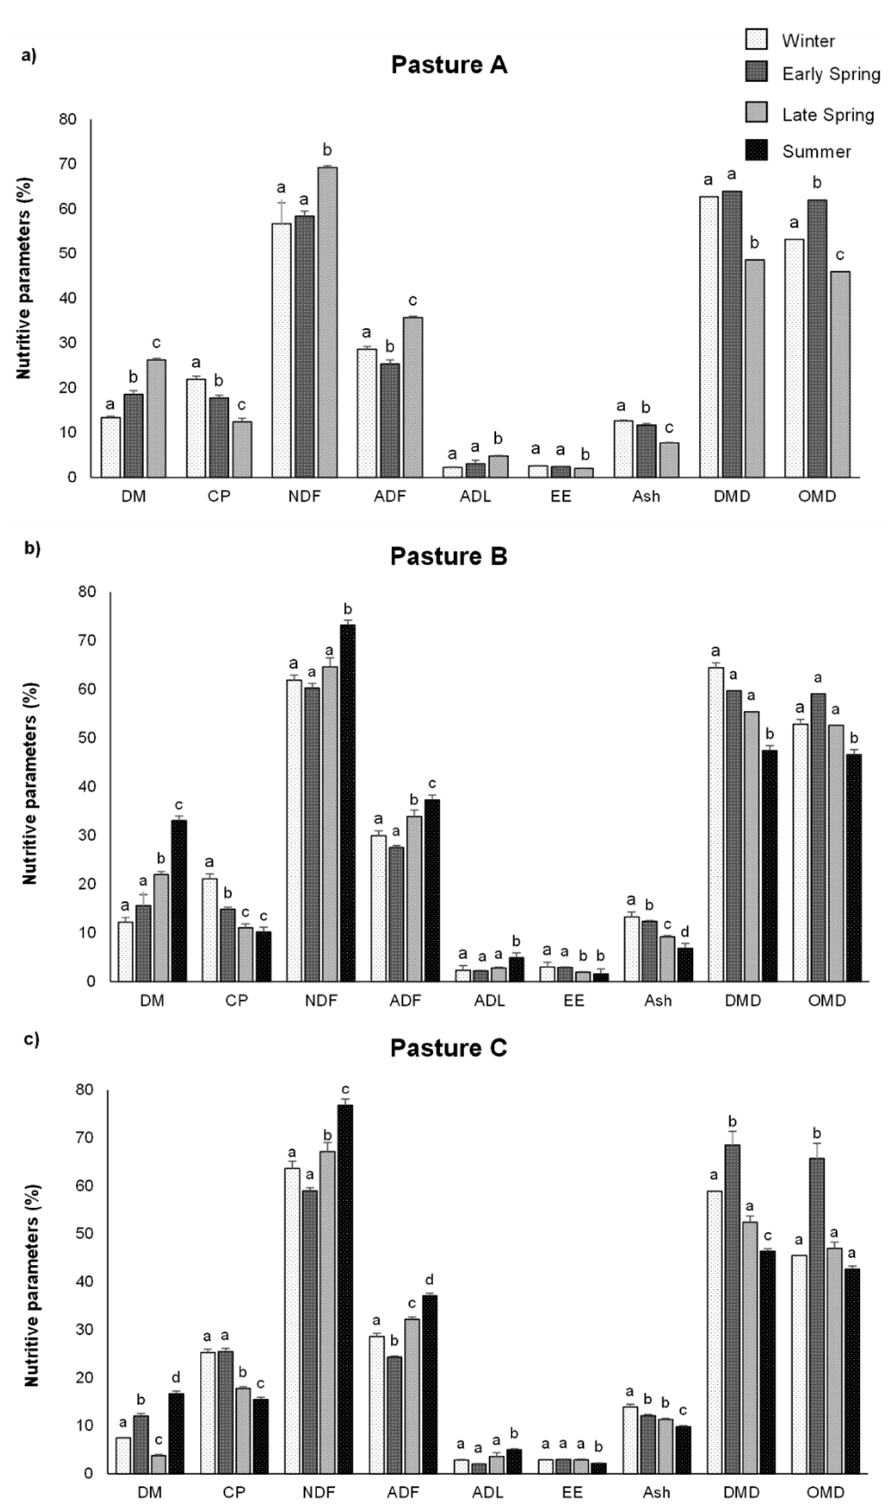
Figure 6. Variation of the nutritive parameters of forage plants among the four sampling dates: winter, early spring, late spring and summer in: ( a ) pasture A, ( b ) pasture B and ( c ) pasture C. Different letters above each bar indicate significant differences in the nutritive parameters among sampling dates (Tukey test, p < 0.05).